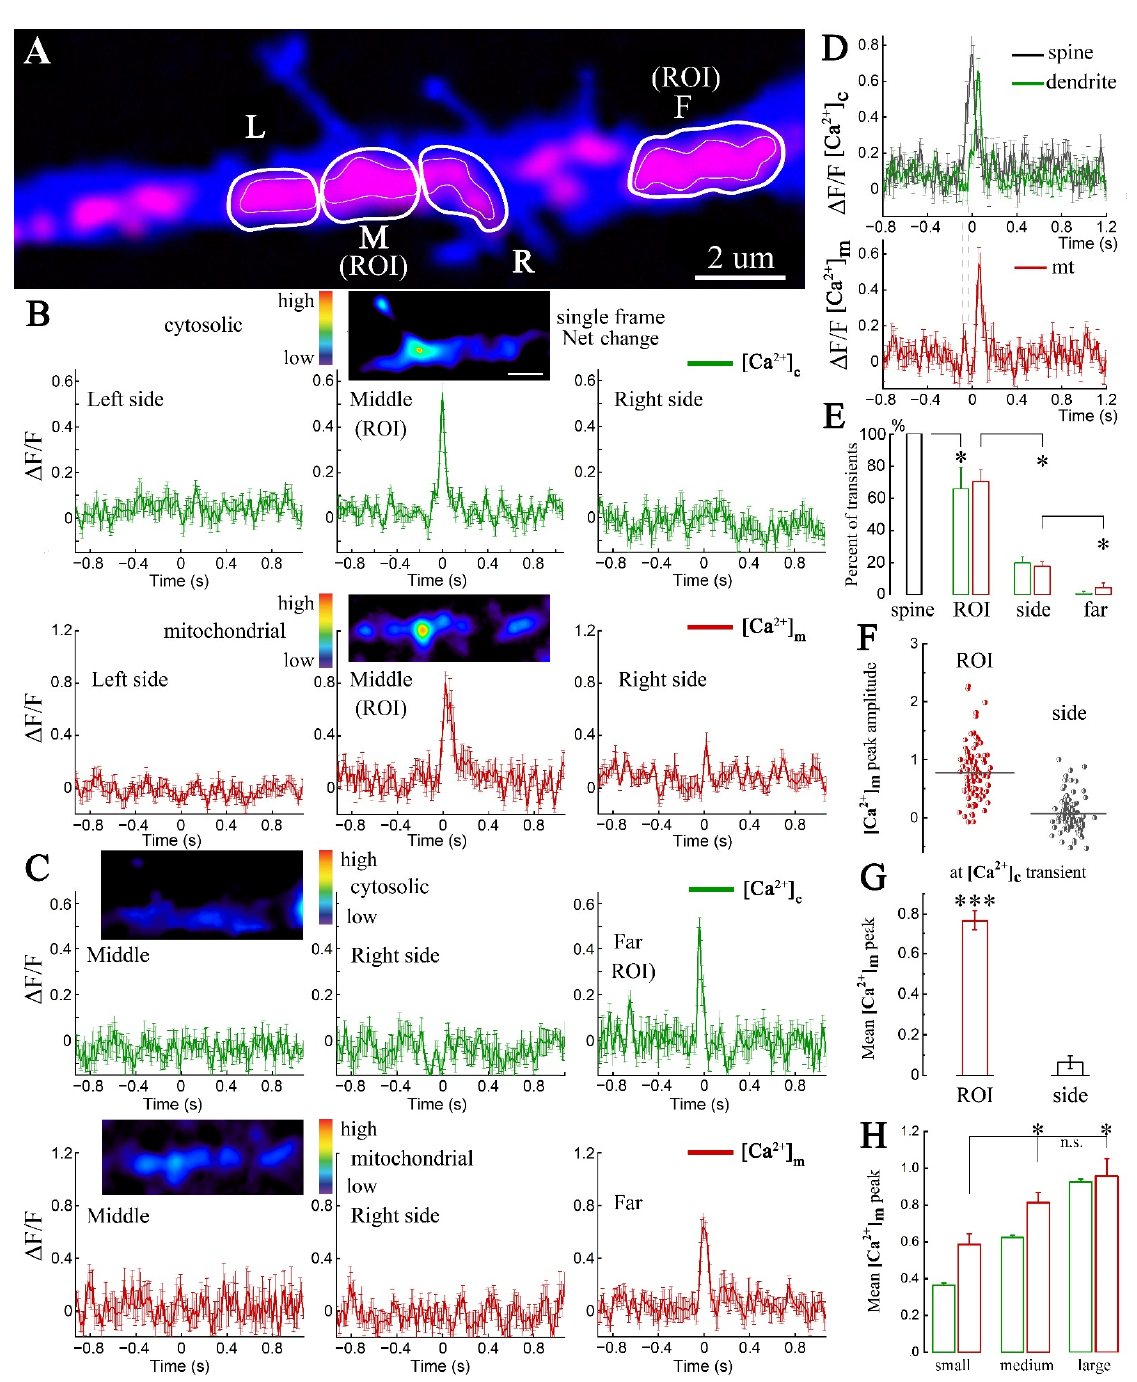
Figure 1. Mitochondrial calcium transients follow spontaneous local calcium events. ( A ). MT clusters (red, mtRCaMP, indicator of mitochondrial calcium ([Ca 2+ ]m)) are marked by thin white boundaries, designate left (L), middle (M), right (R) and far (F) regions in the dendrite (blue, eBFP). The corresponding regions of cytosolic calcium ([Ca 2+ ]c) analysis (left, middle, right and far) are marked